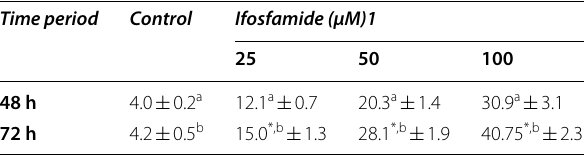
Data represent mean